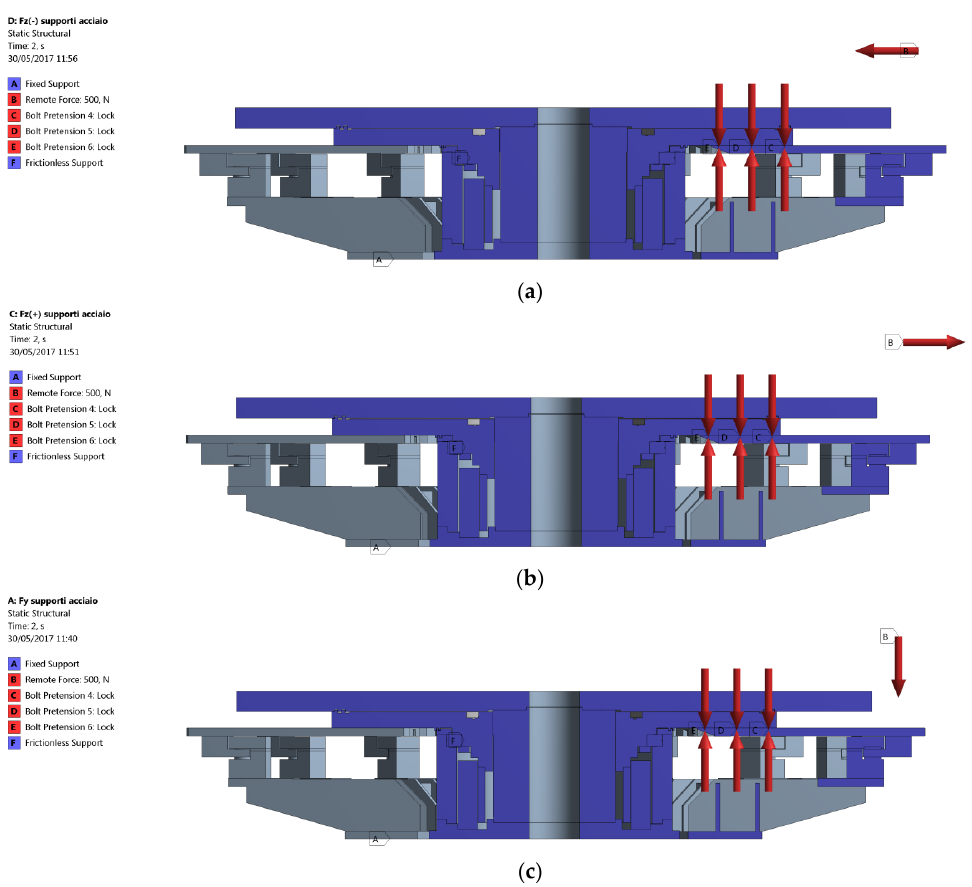
Figure 17. Boundary conditions with forces ( a ) Fz (−) ( b ) Fz (+) ( c ) Fy (−). Bolt preload forces.